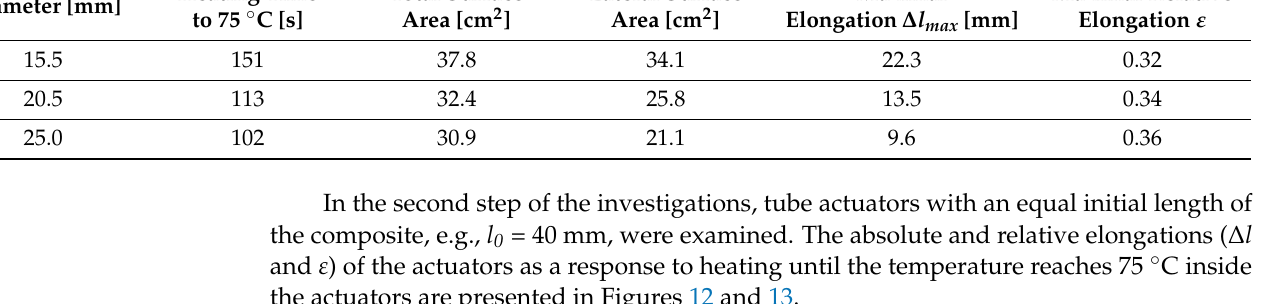
Table 3. The parameters and results of tube actuators with equal volume.